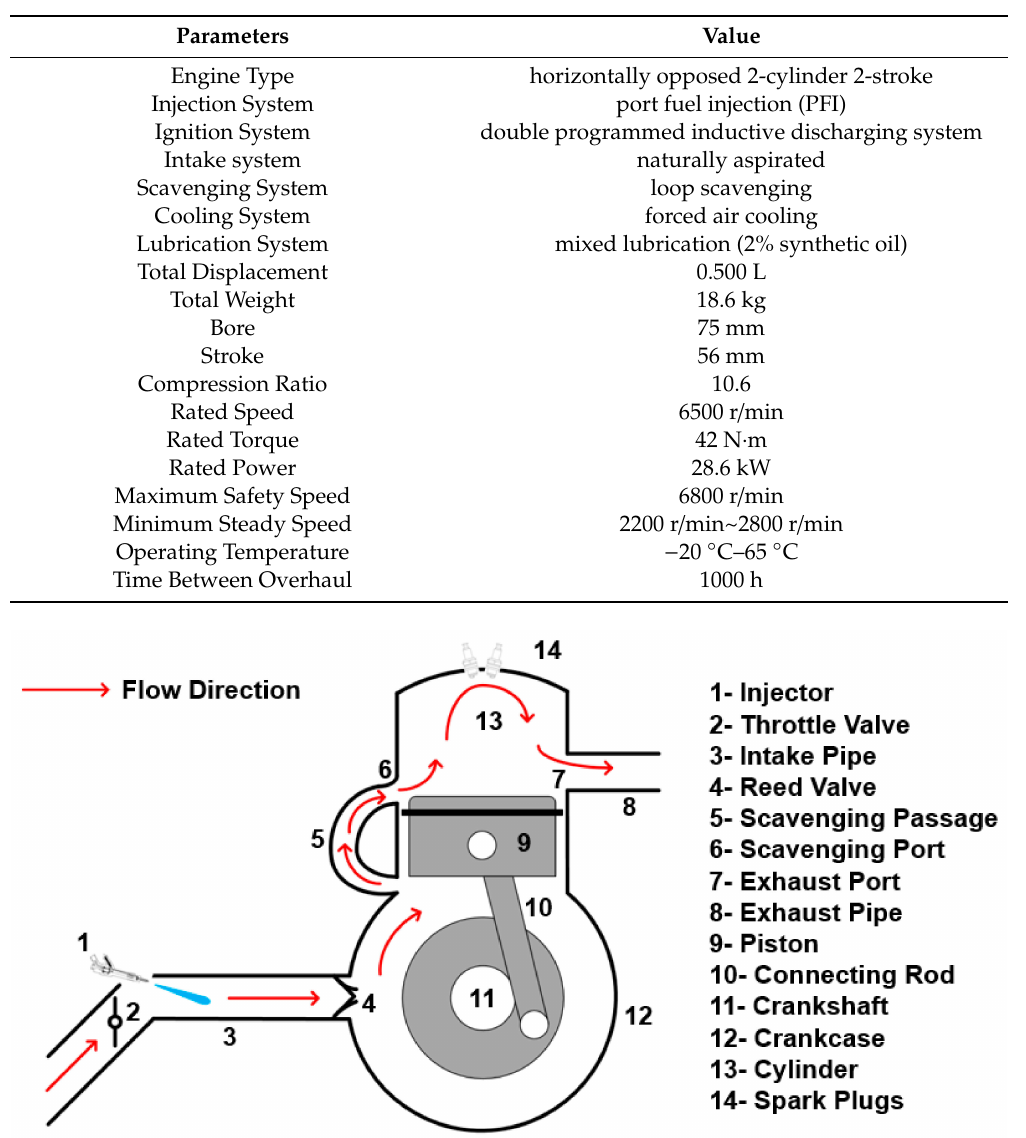
Table 1. Main specifications of the initial prototype engine.